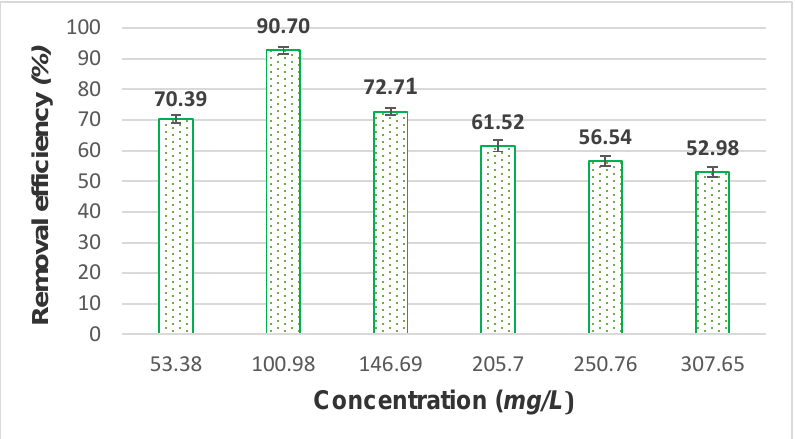
Figure 10. The effect of initial phenol concentration on the phenol removal capability of Fe-Cu material.